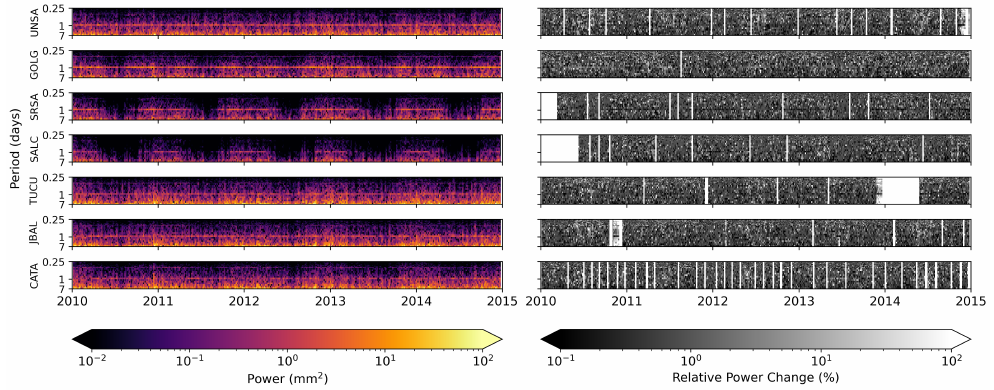
Figure 17. Left: Spectral analysis of the station along the E-W and N-S directions using a seven-day sampling window. This figure can be directly compared to Figure 6. In this case, we employed the ray-tracing derived water vapour using only meteorological information from ERA5 hourly data on pressure levels [38], instead of the GNSS-derived water vapour. Right: Difference in relative response power between the spectrograms of the GNSS- and the ERA5 ray-tracing derived water vapour